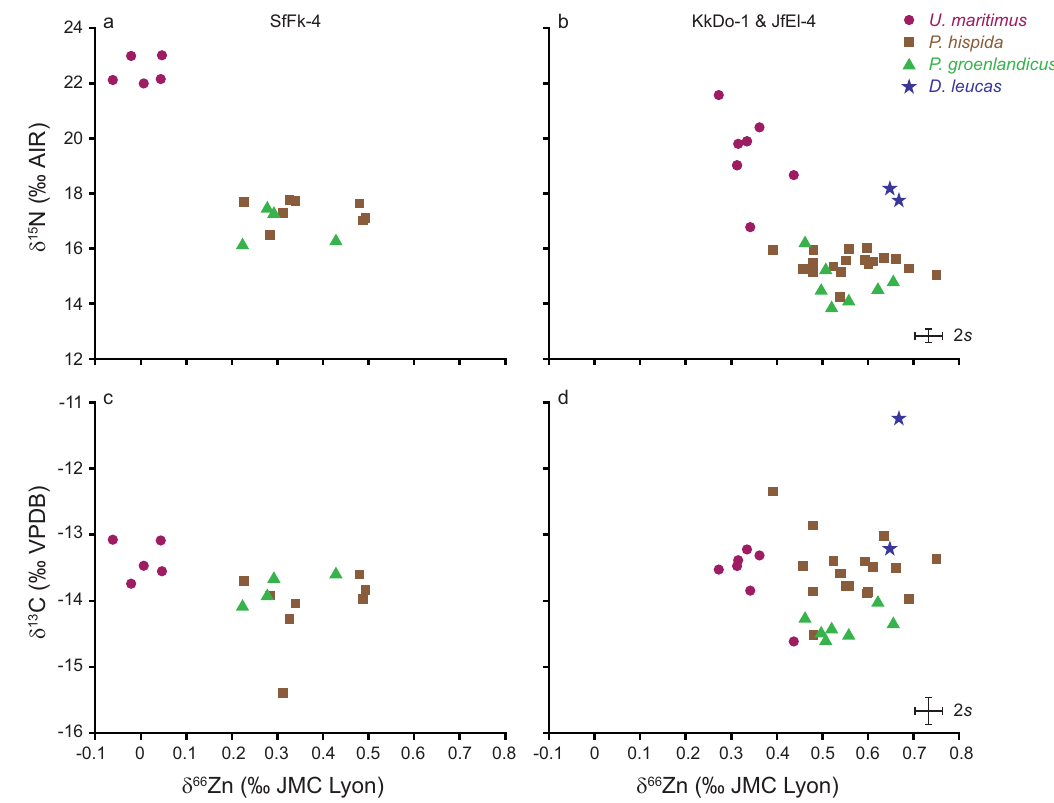
Fig. 3 Isotope values for the SfFk-4 and KkDo-1 & JfEl-4 sites. Isotopic composition ( δ 15 N, δ 13 C versus δ 66 Zn) of U. maritimus (magenta circles), P. hispida (brown squares), P. groenlandicus (green triangle) and D. leucas (blue stars) bones for the SfFk-4 ( a , c ) and combined KkDo-1 and JfEl-4 sites ( b , d ). For ( a ) and ( c ) we present n = 5 U. maritimus , n = 8 P. hispida and n = 4 P. groenlandicus bone samples and for ( b ) and ( d ) n = 7 U. maritimus , n = 18 P. hispida , n = 7 P. groenlandicus and n = 2 D. leucas bone samples. Error bars represent the measurement